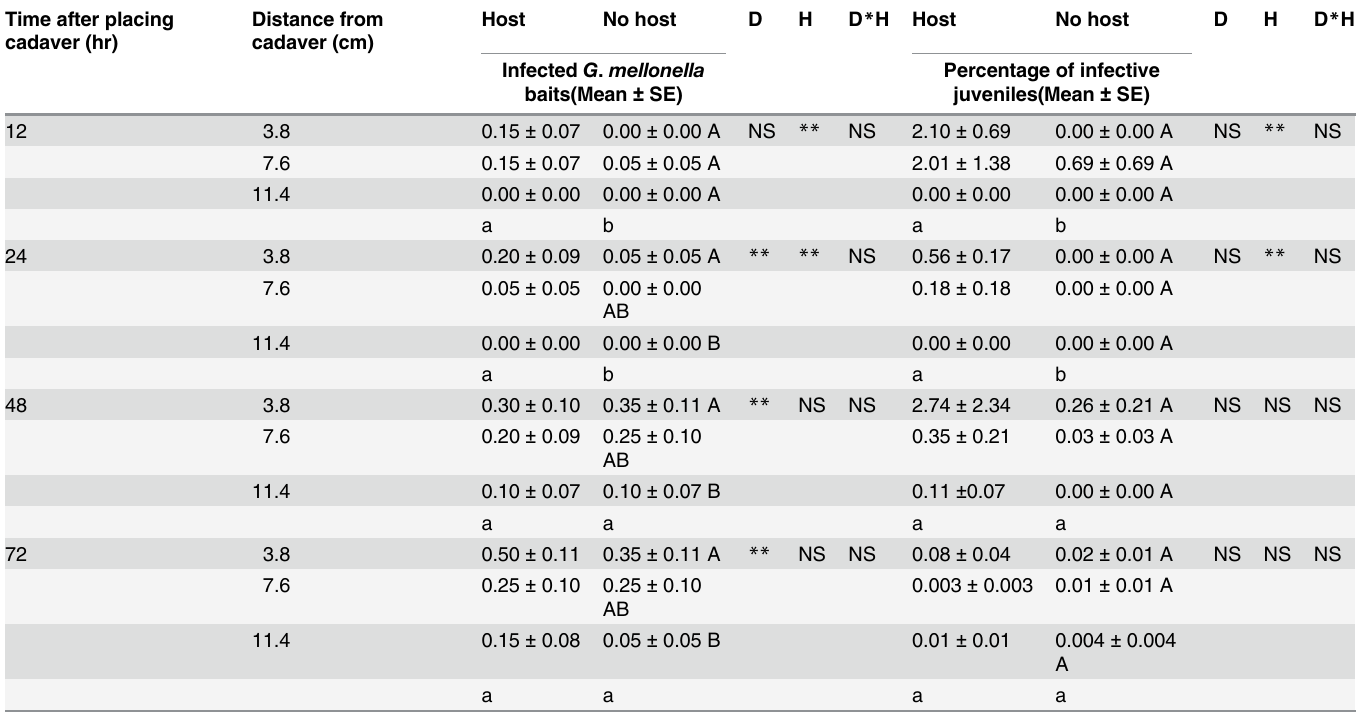
Mean ( ± SE) number of infected Galleria mellonella baits from the collected soil core samples and mean ( ± SE) percentage of infective juveniles (IJs) of Heterorhabditis bacteriophora dispersed to a 2 cm wide arc at distances, 3.8, 7.6 and 11.4 cm over a period of 12 to 72 hr in the presence of a live non- mobile host, G . mellonella larva contained in a wire mesh cage buried in one of the quadrants in the microcosms containing autoclaved fi eld soil with vegetation in comparison with the opposite quadrant of the same microcosm containing no host. Double asterisk ( ** ) indicates signi fi cant difference between distances (D), presence or absence of the host (H) and interaction between the two (D * H) at a time point at P (cid:1) 0.05. Capital and small letters indicate Tukey ’ s comparison for means separation between distances averaged over presence or absence of the host, and presence and absence of host averaged over distances, respectively at a time point. NS = P >